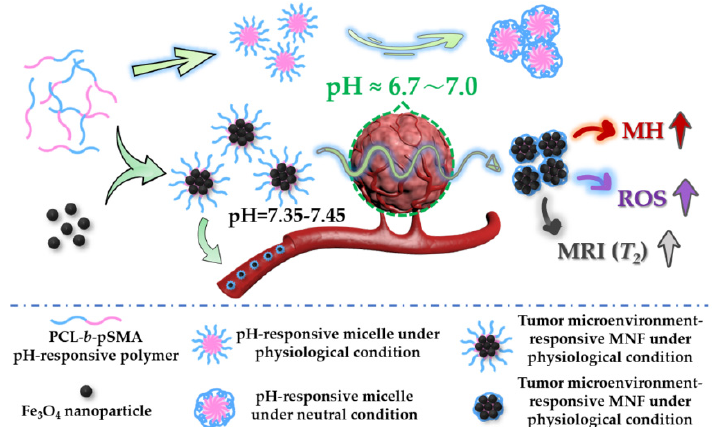
Figure 1. Schematic illustration of the tumor microenvironment-responsive MNF, which was pre- pared by self-assembly of Fe 3 O 4 nanoparticles and pH-responsive polymer. According to the phase transition of the pH-responsive micelles under a neutral condition, the tumor microenvironment- responsive MNF could maintain an individual state and form aggregations in tumor microenviron- ment to improve tumor MH, ROS generation and MRI simultaneously.